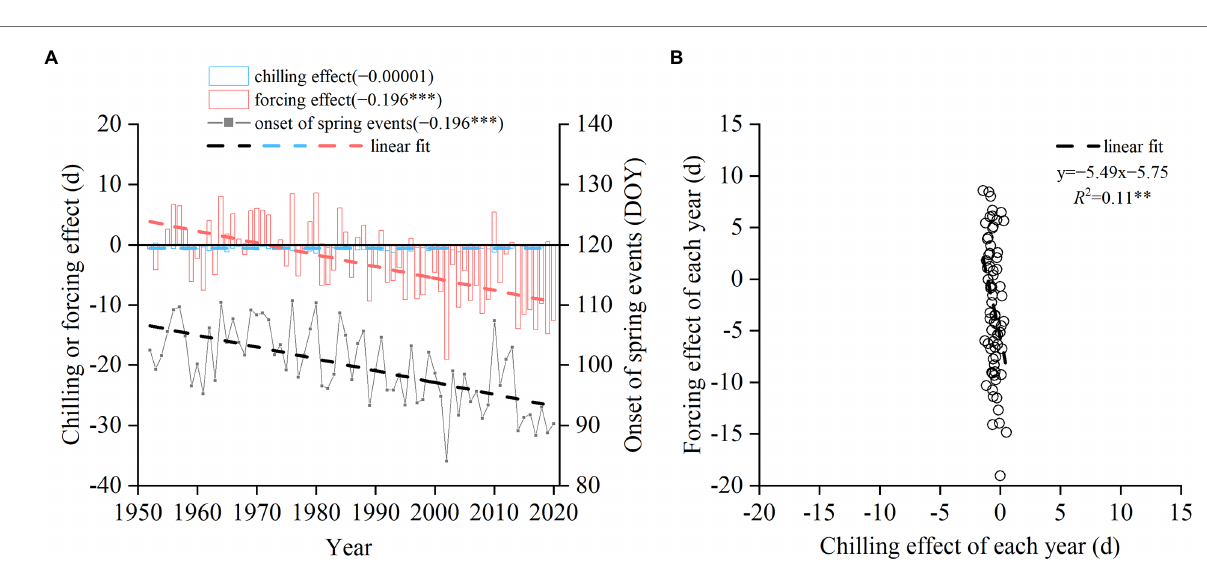
( Figure 3B , p = 0.90). For example, F. chinensis and J. nudiflorum